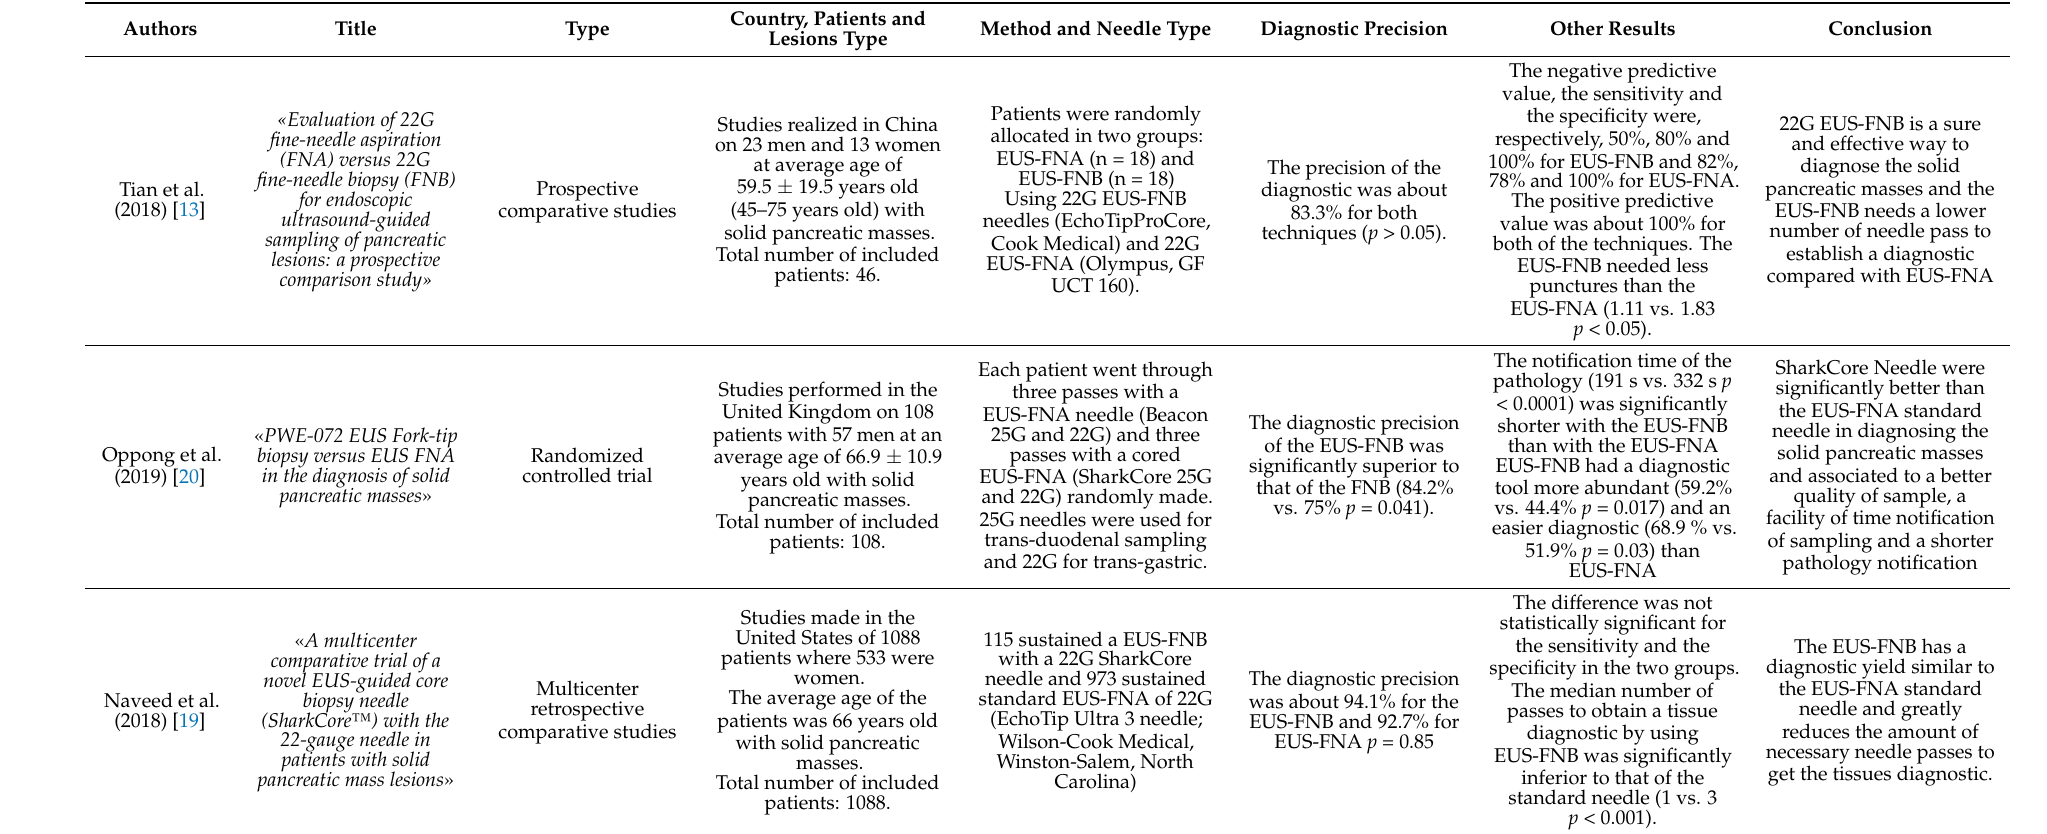
Table 1. Retained studies